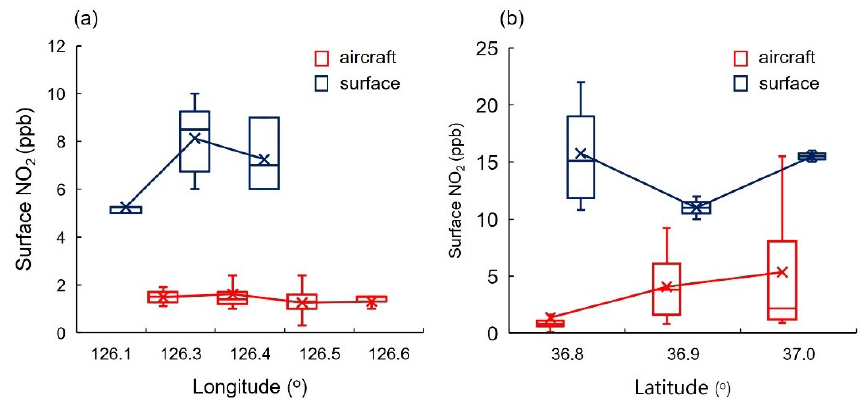
Figure 10. Latitudinal NO 2 distribution at the surface and 600m over PA 4 (Seosan super site), averaged during (a) 13:00–16:00KST on 6 December (FL-5) by longitude and (b) 12:00–14:00KST on 9 December (FL-7) by latitude, obtained from airborne (blue) and surface measurements